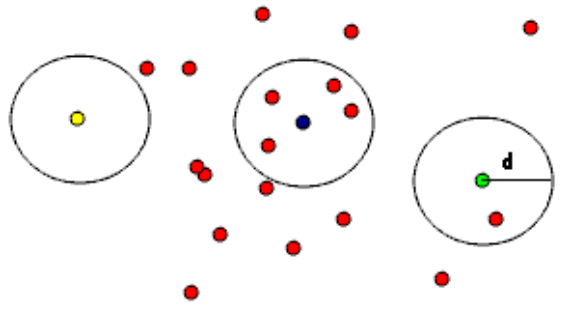
Figure 4. RadiusOutlier removal schematic.